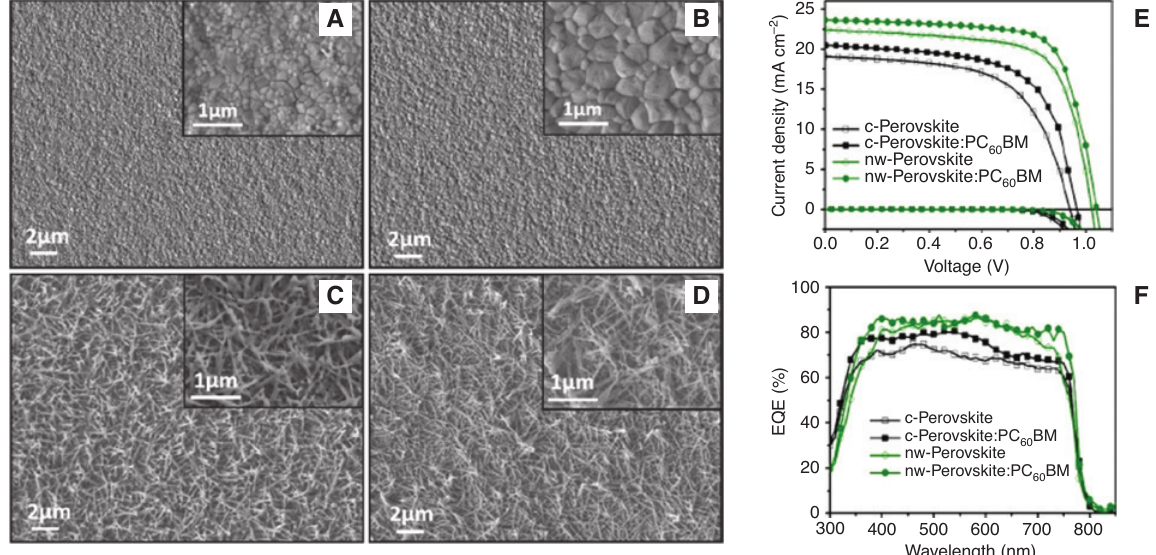
NH PbI nanowires in perovskite solar cells. Figure 3: CH 3 3 3 Scanning electron microscopy (SEM) images of the c-perovskite (compact): (A), c-perovskite: PC perovskite nanowires: PC BM (D) films. J-V characteristics measured under sun and dark conditions (E), and EQE spectra for the highest- 60 performing films (F). Reproduced with permission from [103]. Copyright 2018,